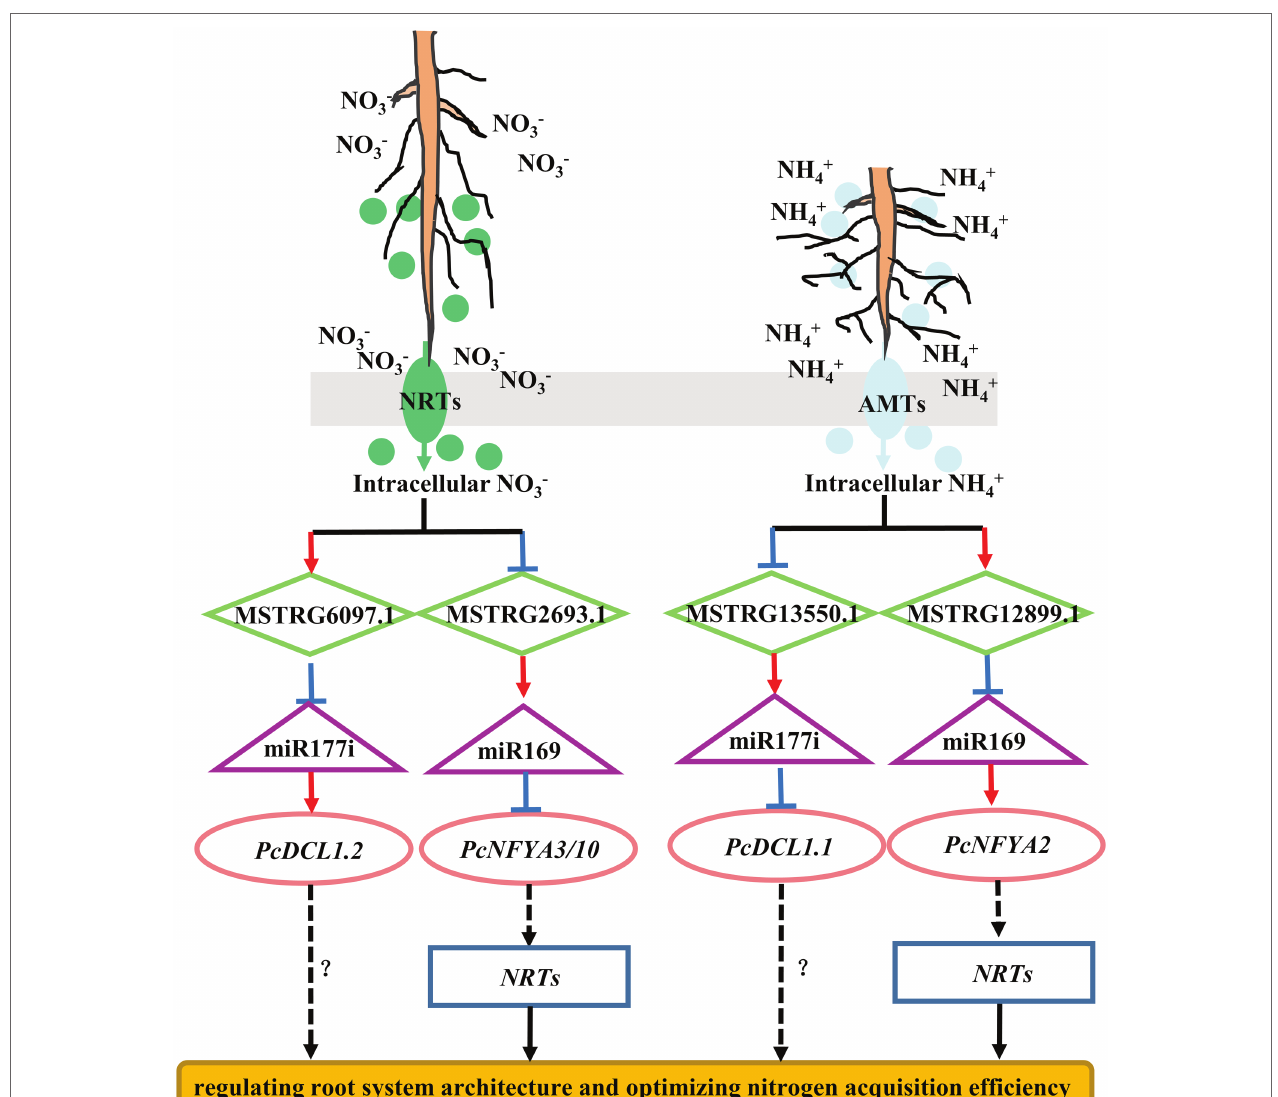
FIGURE 9 | Simple model illustrating MSTRG.6097.1, MSTRG.13550.1, MSTRG.2693.1 and MSTRG.12899.1 as hub lncRNAs in the ceRNA networks. The target genes CDL1 and NFYAs may enable woody plants to optimize nitrogen acquisition efficiency by regulating root system architecture and nitrogen uptake acticity under different nitrogen fertilization treatments. The arrow indicates positive regulation; the T-line represents negative regulation. The solid line represents the experimentally determined pathway, and the dotted line represents the predicted